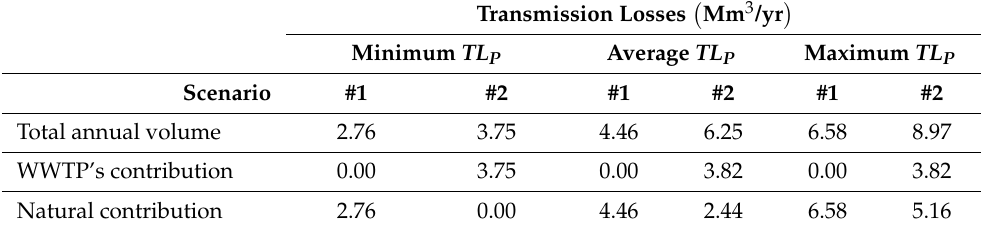
Table 4. Estimated mean annual volumes of riverbed transmission losses for minimum, average, and maximum TL P values. Fractions attributable to natural flow (i.e., rainfall-runoff) and WWTP discharge,